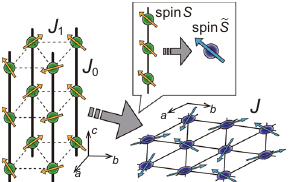
Fig. 2 Squash mapping. Illustration of the concept of mapping from coupled-chain model with spin S , intrachain coupling J 0 , and interchain coupling J 1 to an effective single-layer model with spin ~ S and coupling J .